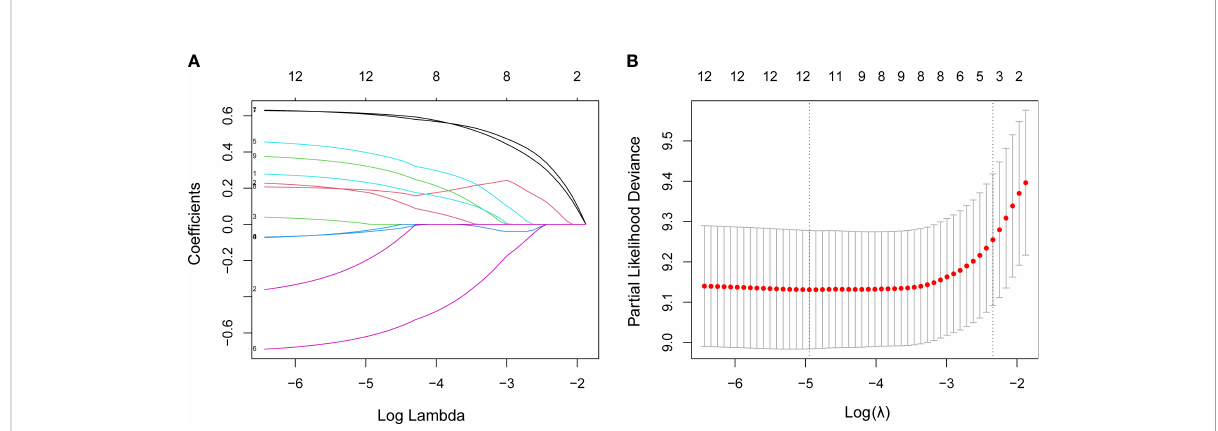
FIGURE 5 LASSO regression analysis performed feature selection on 12 in fl ammatory markers using a 5-fold cross-validation method. (A) Coef fi cient pro fi le diagram. Each curve in the fi gure represents the change trajectory of each independent variable coef fi cient. The ordinate is the value of the coef fi cient, and the abscissa is the number of non-zero coef fi cients in the model. With the constant value of the penalty parameter lambda increases, the fi nal variable coef fi cient gradually approaches 0. (B) The left dashed line corresponds to the l value with the smallest mean square error, and the right dashed line corresponds to the l value of the simplest model within a variance range of the minimum l